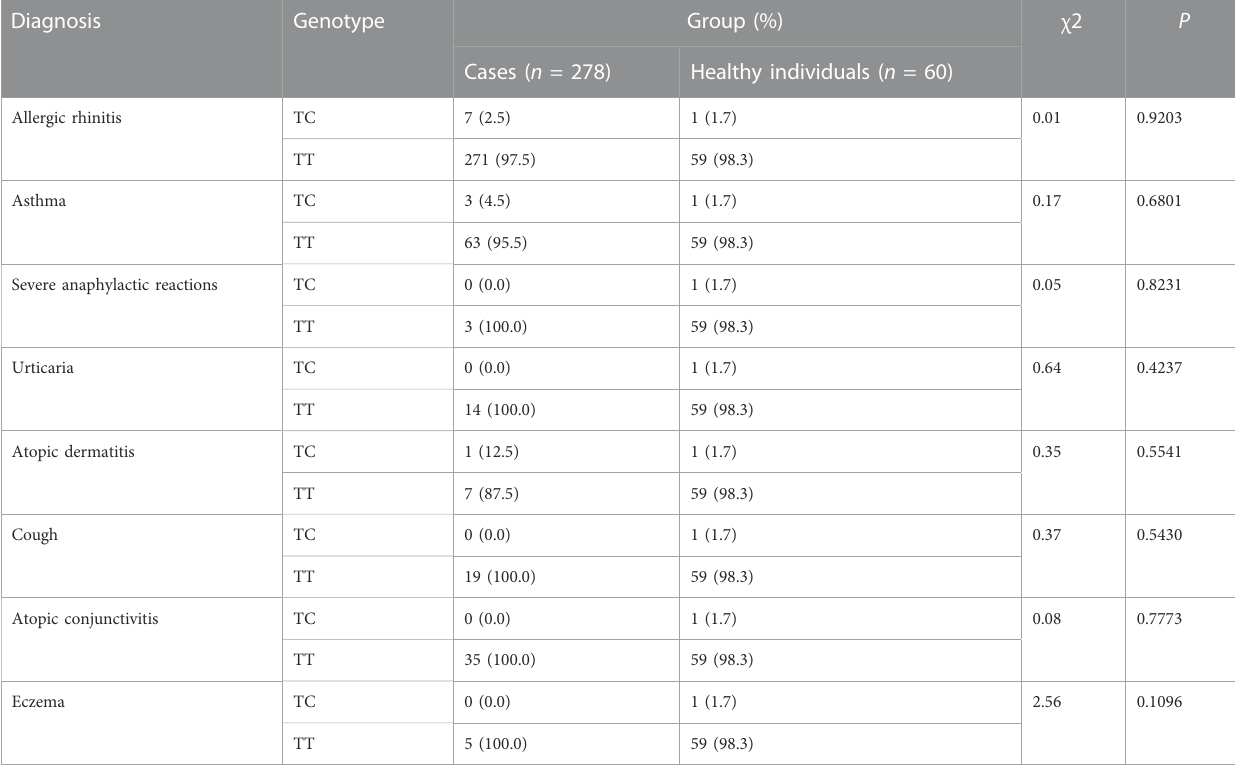
TABLE 5 Analysis of Association of GPIIIa rs5918 (T176C) with Genetic Susceptibility to Diagnosis.